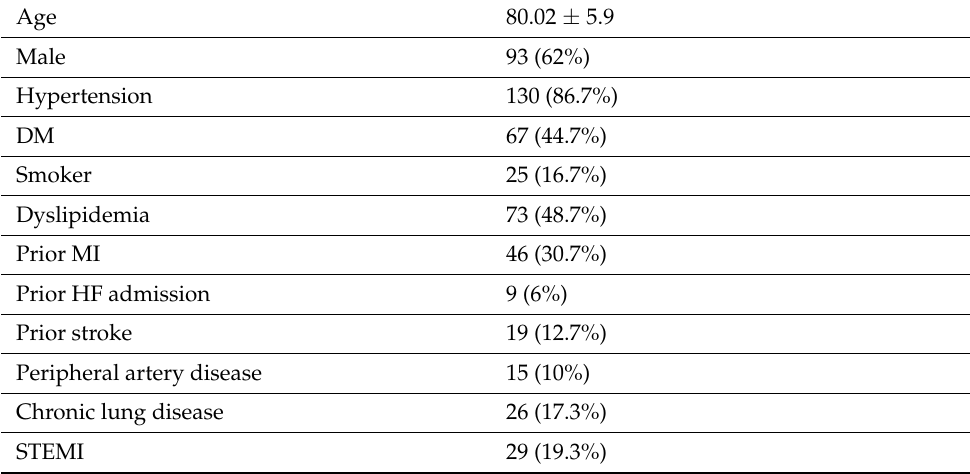
Table 1. Baseline characteristics, n = 150. Values are expressed as mean ± standard deviation or number